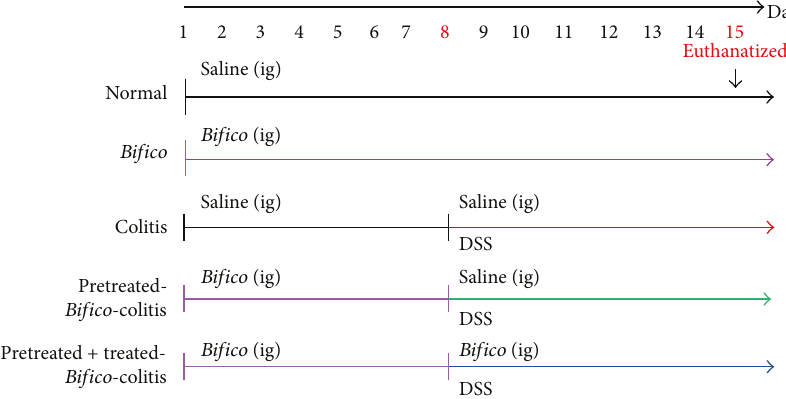
Figure 1: Schematic illustrations of the experimental protocols used in this study. A total of 44 female BALB/c mice were randomly assigned into 5 groups. Normal ( n = 11 ), Bi fi co ( n = 8 ), colitis ( n = 8 ), pretreated- Bi fi co -colitis ( n = 9 ), and pretreated +treated- Bi fi co -colitis ( n = 8 ). ig: intragastric